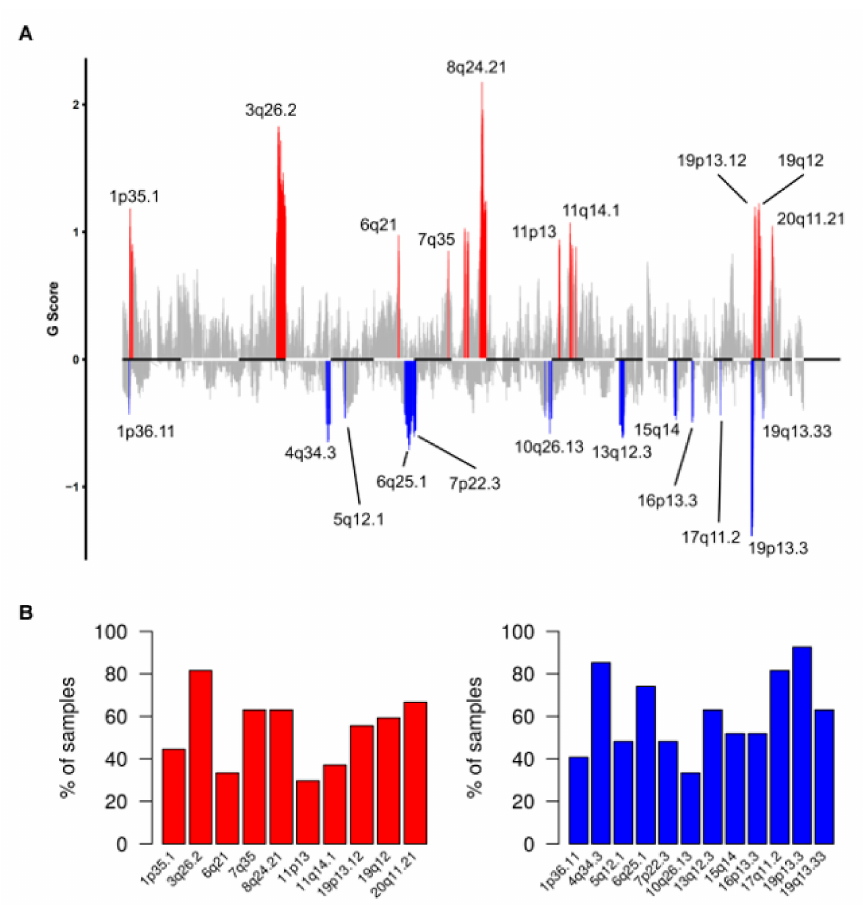
Figure 4. Recurrent somatic copy number alterations (sCNA) in R0 patients of TCGA-OV27 cohort. ( A ) Plot of G scores (defined as the amplitude of the copy number multiplied by its frequency across samples) calculated by Genomic Identification of Significant Targets in Cancer (GISTIC) for genomic regions recurrently amplified (red) or deleted (blue) in the TCGA-OV27 dataset, at an FDR < 0.1. ( B ) Barplot showing the frequency of samples positive for the recurrently amplified (left) or deleted (right) regions identified by